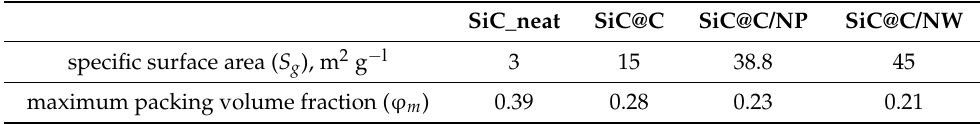
Table 1. The maximum value of the filler’s volume fraction in the